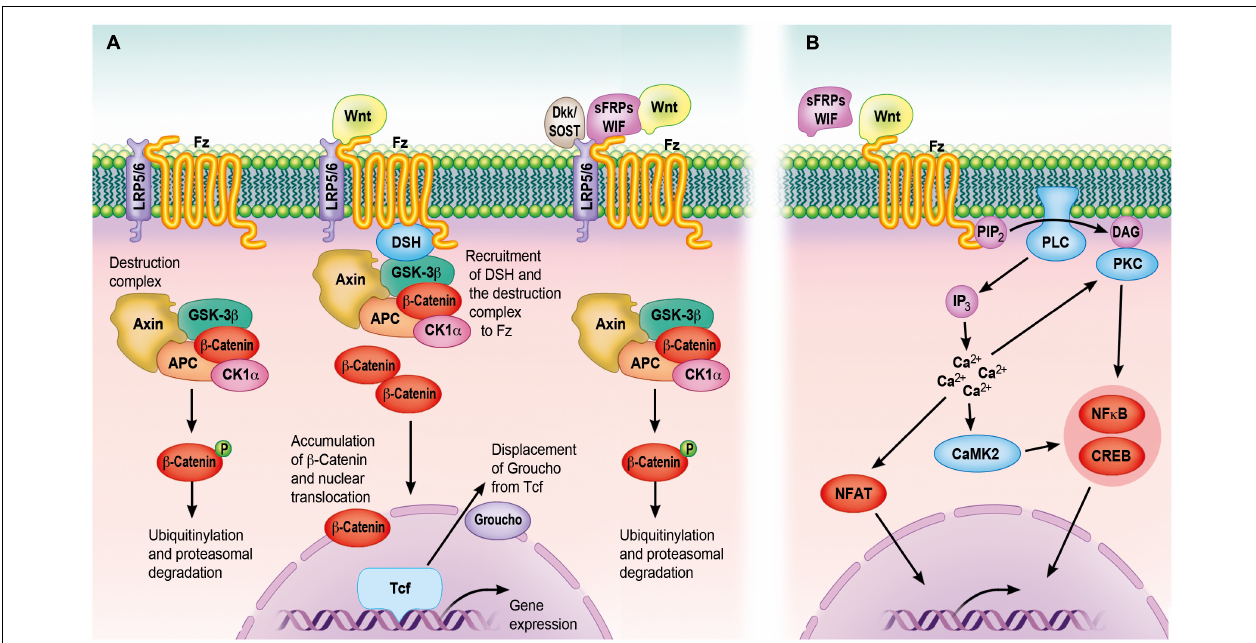
FIGURE 2 | The Wnt signaling cascades. (A) The canonical Wnt signaling cascade depends on β -catenin, which serves as an intracellular signaling molecule. In case Wnt is not binding to Fz receptors, β -catenin is sequestered into a destruction complex composed of Axin, CK1 α , APC and GSK3 β , phosphorylated, ubiquitinylated and subsequently degraded by the proteasome. Following the binding of Wnt to Fz receptors and LRP5/6 co-receptors, DSH recruits the destruction complex to the cell membrane by interacting with the receptor complex. This allows newly synthesized β -catenin to accumulate within the cytoplasm and to translocate to the nucleus. By displacing the transcriptional co-repressor groucho from TCF transcription factors, nuclear β -catenin can activate a gene transcription program, whereas Wnt-binding antagonists (sFRPs/WIF) and Wnt receptor antagonists (Dkk/SOST) inhibit the canonical cascade. (B) The non-canonical Wnt signaling cascade is characterized by the activation through phosphorylation cascades, which are themselves activated by specific ligand–receptor interactions, seemingly without engagement of the LRP co-receptors. Increasing intracellular Ca 2 + levels following PLC- and DAG production can trigger many of these cascades. Subsequently, PKC and CaMKII can activate transcription factors like NF κ B and CREB, mediated IP3 and calmodulin is involved in the activation of NFAT. However, only the Wnt-binding antagonists are able to inhibit the non-canonical cascade. APC, adenomatous polyposis coli; CaMKII, calcium/calmodulin-dependent protein kinase type II; CK1 α , caseine kinase 1- α ; CREB, cyclic AMP-responsive element-binding protein; DAG, diacylglycerol; Dkk, Dickkopf; DSH, disheveled; GSK3 β , glycogen synthase kinase-3 β ; IP3, inositol 1,4,5-triphosphate; LRP, low-density lipoprotein receptor-related protein; NFAT, nuclear factor of activated T cells; NF κ B, nuclear factor κ B; PIP2, phosphatidylinositol 4,5-bisphosphate; PKC, protein kinase C; PLC, phospholipase C; sFRPs, secreted frizzled-related proteins; SOST, sclerostin; WIF, Wnt inhibitory